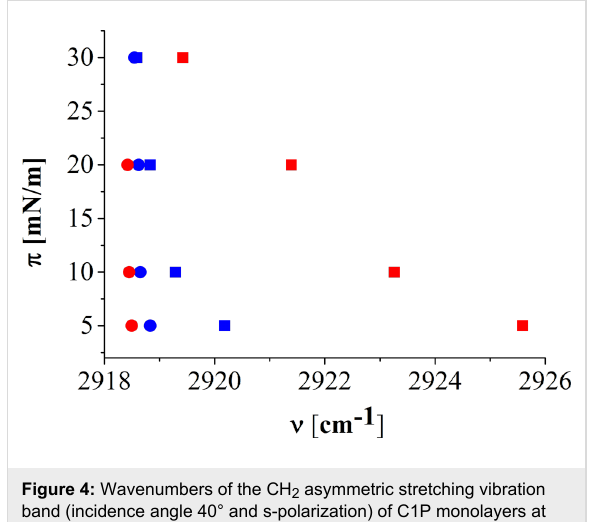
Figure 4: Wavenumbers of the CH 2 asymmetric stretching vibration band (incidence angle 40° and s-polarization) of C1P monolayers at 30 °C on different subphases: (red square) pH 9 without calcium (borax buffer with 150 mM NaCl and 1 mM EDTA), (red circles) pH 9 with calcium (borax buffer with 1 mM Ca 2+ and 150 mM NaCl), (blue squares) pH 4 without calcium (citric buffer with 150 mM NaCl and 1 mM EDTA), and (blue circle) pH 4 with calcium (citric buffer with 1 mM Ca 2+ and 150 mM NaCl), determined by IRRAS.